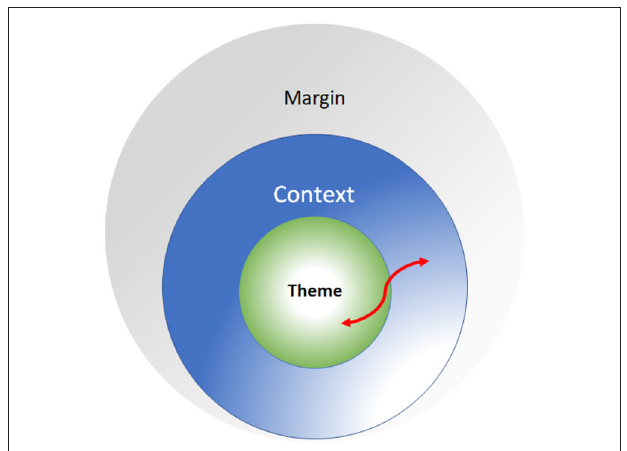
FIGURE 4 | Serial